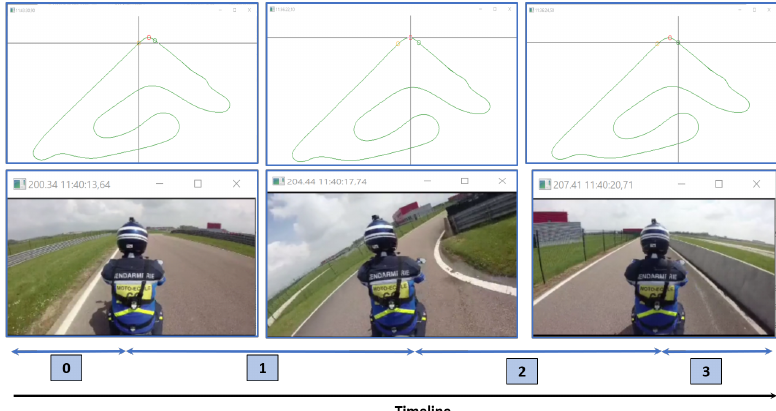
Figure 9. Average of three trials of subject S4 in the FR instruction. The curve maneuver is divided into four phases: Phase 0, Phase 1, Phase 2, and Phase